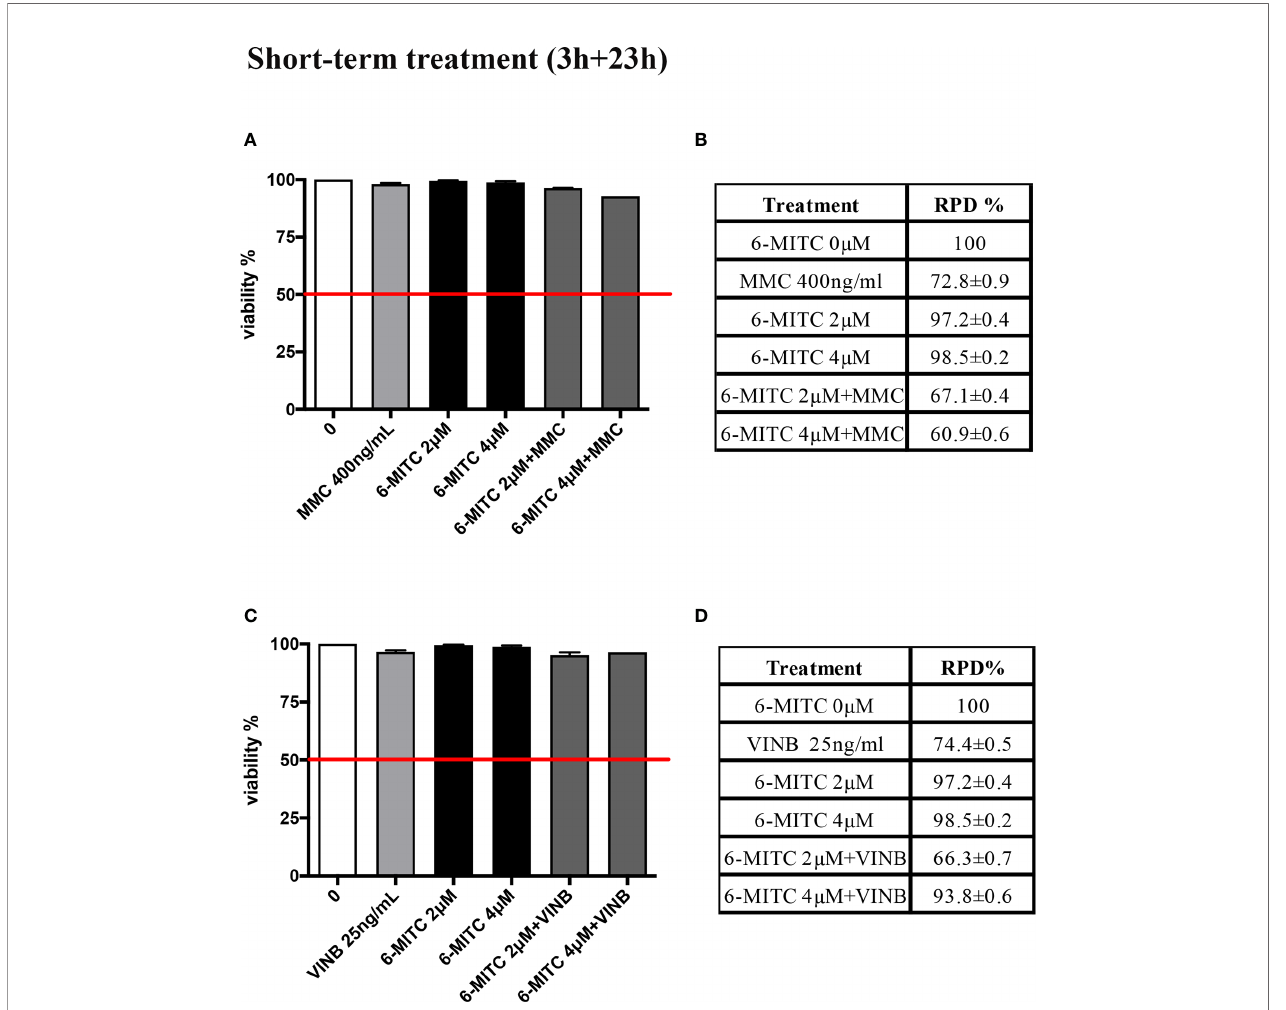
FIGURE 8 | Effect of 6-MITC on cytotoxicity and cytostasis after short term treatment Percentage of viability in TK6 cells treated with 6-MITC for 3h followed by 23h of recovery in complete medium in presence or absence of MMC 400ng/mL (A) or VINB 25ng/mL (C) and relative RPD values for MMC 400ng/mL (B) or VINB 25ng/mL (D) . Data represents the mean ± SEM of fi ve independent experiments. Data were analysed using repeated ANOVA followed by Dunnet